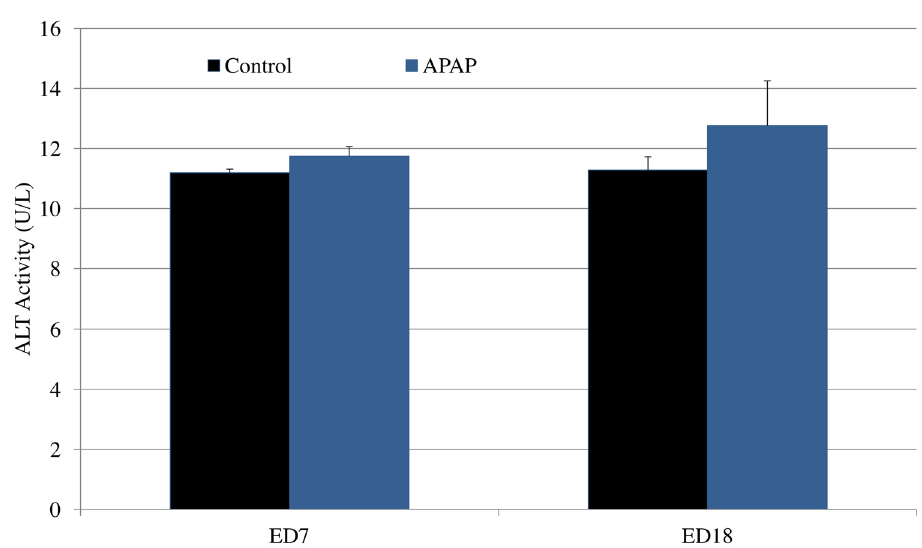
Table 1. Incidence rate ratio (95% confidence interval) of different activities for treatment group compared to control group: mixed effects poisson regression analysis that adjusted for offspring weight, gender, random selection, and testing time and day. P < 0.008 was considered significant. TLMA Rear Central Peripheral Fine Total Treatment group (vs. control